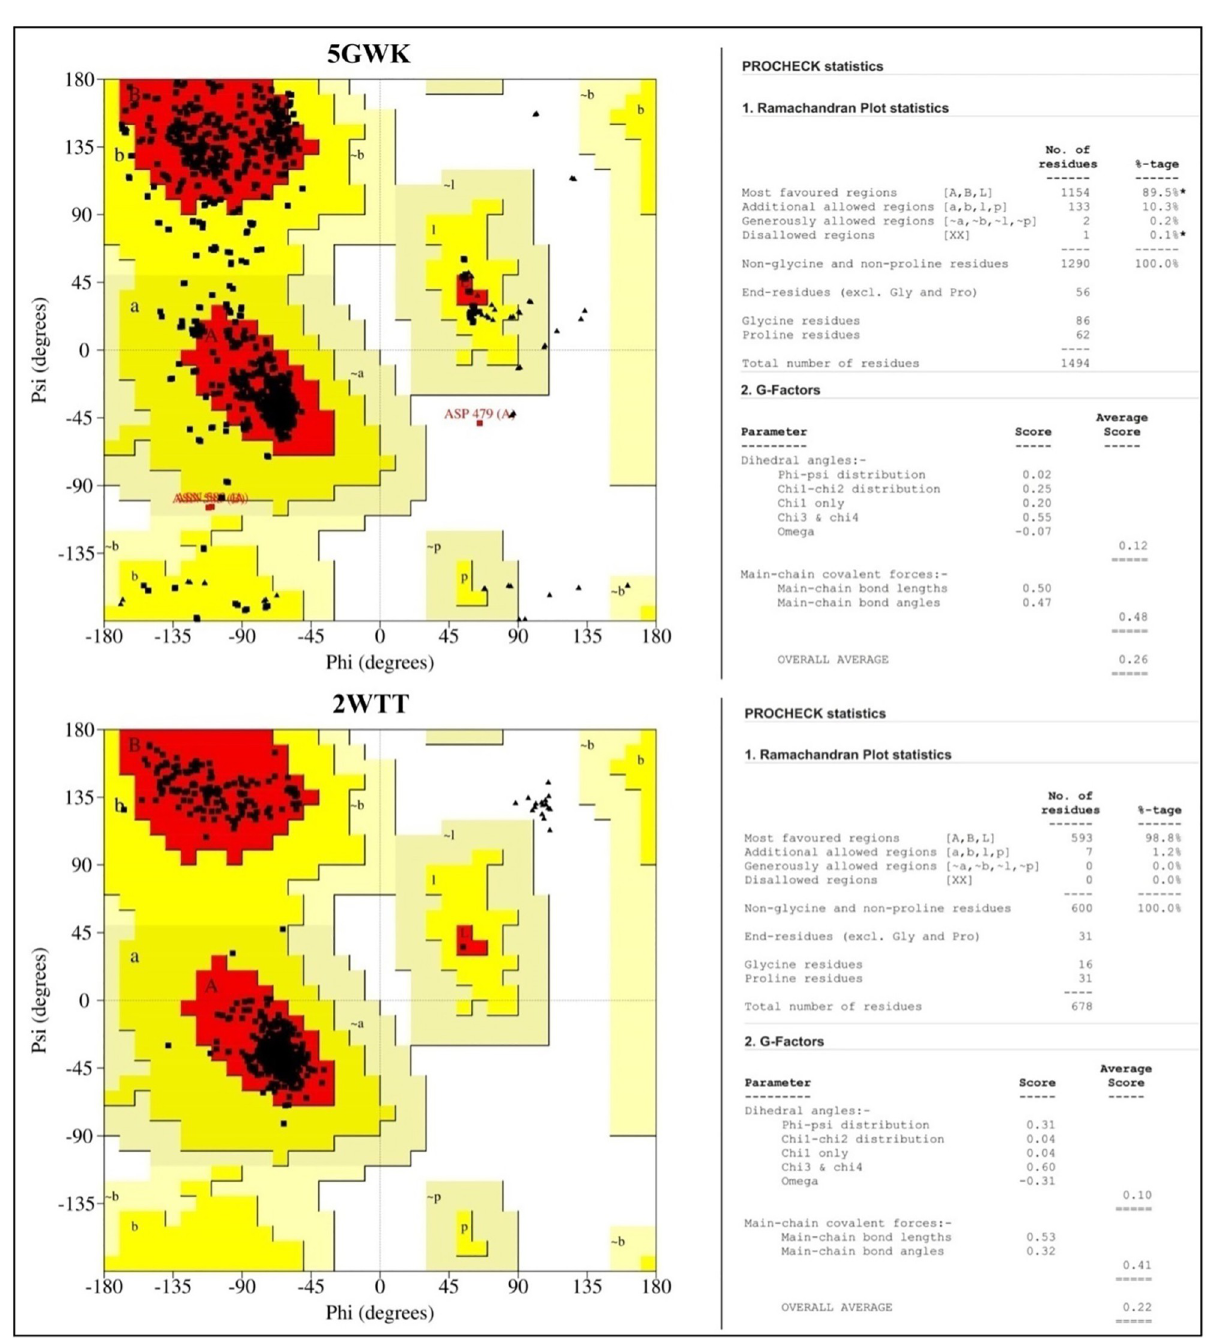
Fig 2. Ramachandran plot for the model of the structure of human TOP2A (PDB: 5GWK) and human p73 tetramerization domain (PDB: 2WTT) proteins generated by PROCHECK. The red color region denotes residues of the protein in the most favored regions; the brown color denotes residues in the additional allowed regions and the yellow indicates residues in the generously allowed